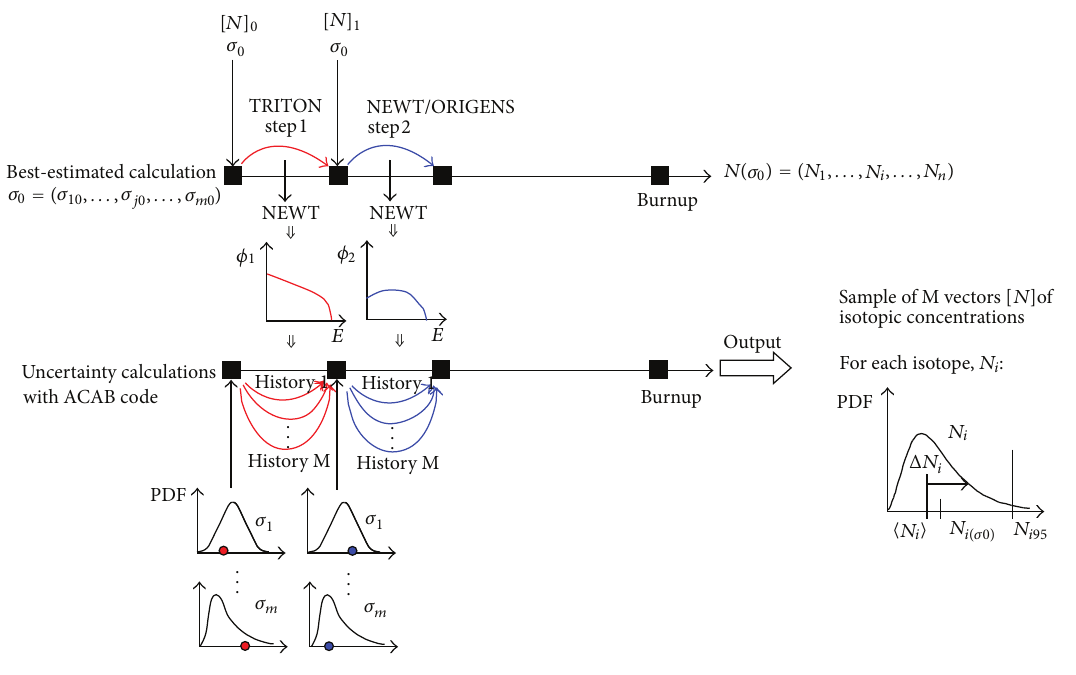
F 6: A Hybrid method used by ACAB